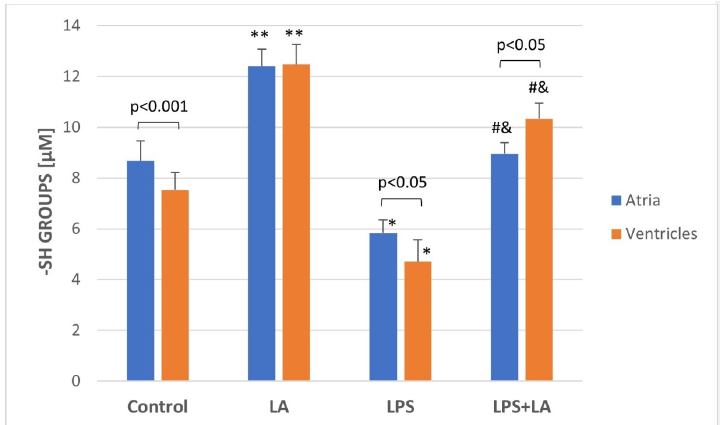
Figure 6. Effect of LA, LPS, and LPS + LA on sulfhydryl groups (-SH) content in ventricular and atrial homogenates. Results are shown as mean ± S.E.M. n = 8. * p < 0.05 vs. control, LA; # p < 0.01 vs. LPS; and p < 0.05 vs. control, LA; ** p < 0.05 vs. control. LA—alpha lipoic acid, LPS—lipopolysaccharide.